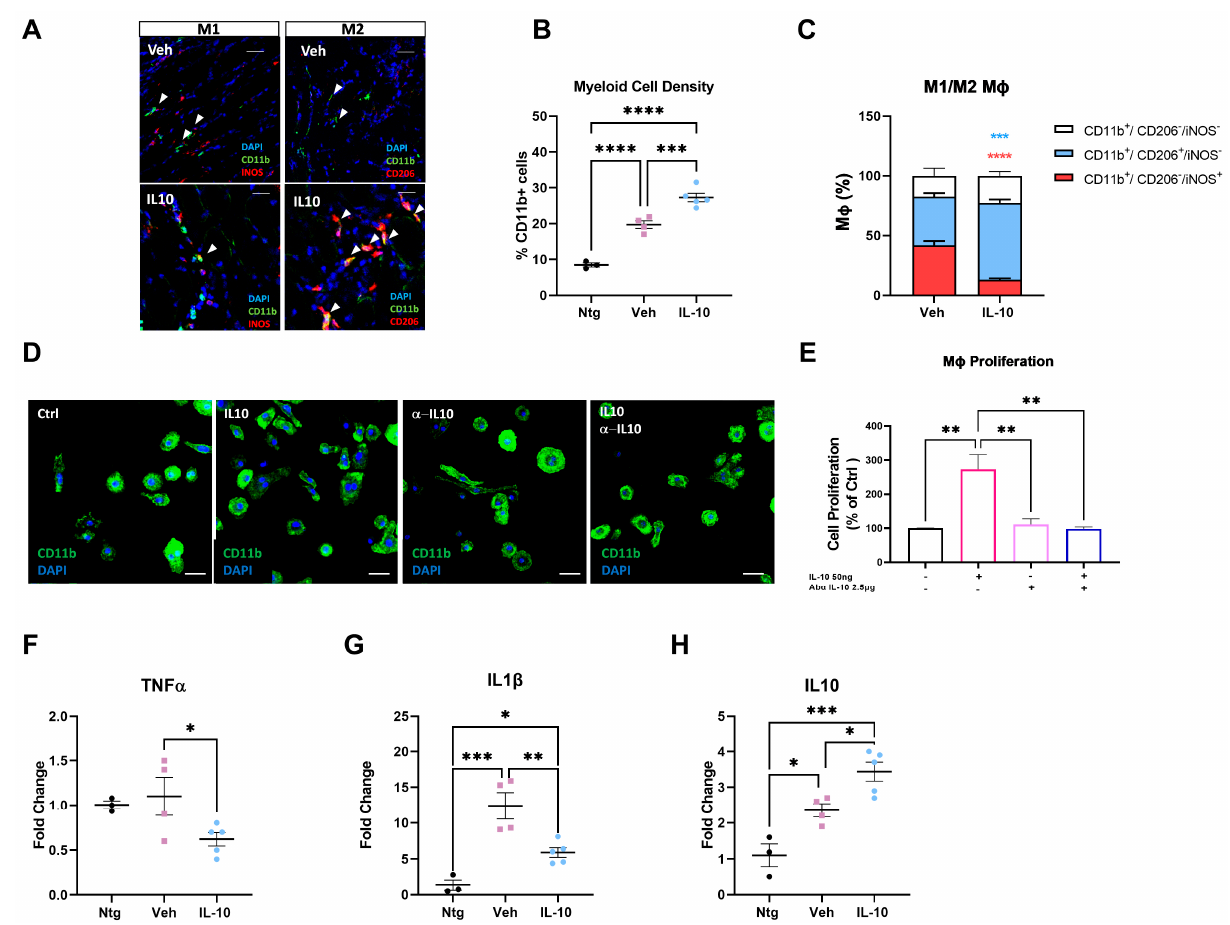
Figure 4. Intramuscular IL-10 administration promotes macrophage polarization to M2 pro-regenerative fingerprint in the skeletal muscles of C57-SOD1G93A mice. ( A ) Representative confocal images showing the distribution of M ф- M1s (CD11b+/iNOS+) and M ф- M2s (CD11b+/CD206+) in longitudinal TA muscle sections of C57-SOD1G93A mice treated once daily with IL-10 or PBS at 12 weeks of age for 15 days (scale bar = 100 µ m). ( B , C ) Quantification of M Φ infiltration ( B ) and fingerprint of M ф- M1s (CD11b+/iNOS+) and M ф- M2 (CD11b+/CD206+) ( C ) within the TA of IL-10 and vehicle-treated groups. The data are reported as (mean ± SEM) from at least five independent ex- periments for each group. *** p < 0.001, **** p < 0.0001 by one-way ANOVA with Tukey’s post-analysis. ( D ) Representative confocal images showing the proliferation of M ф s stimulated with IL-10 in the presence or absence of anti-IL-10 antibody (scale bar = 50 µ m). ( E ) Quantification of M ф proliferation by trypan blue exclusion. The data are reported as (mean ± SEM) from at least three independent experiments. ** p < 0.01 by one-way ANOVA with Tukey’s post-analysis. ( F – H ) Real-time qPCR for TNF α ( F ), IL-1 β ( G ), and IL-10 ( H ) mRNA transcripts in TA muscles at 14 weeks of IL-10 and PBS-treated C57-SOD1G93A mice compared to Ntg littermates. The data are presented as (mean ± SEM) of n = 4–5 independent experiments for each group. The data are reported as (mean ± SEM). * p < 0.05, *** p <0.001 by one-way ANOVA with Tukey’s post-analysis.